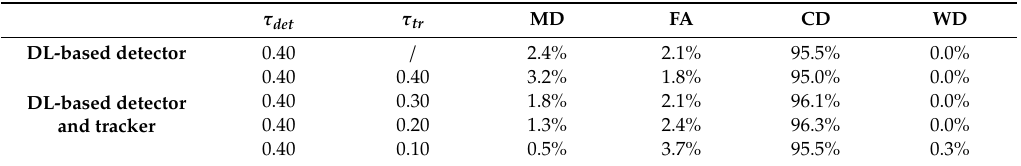
Table 5. DL-based detector vs. DL-based detector and tracker performance as a function of τ tr ( τ det = 0.40). FT3-A composed of 381 frames.